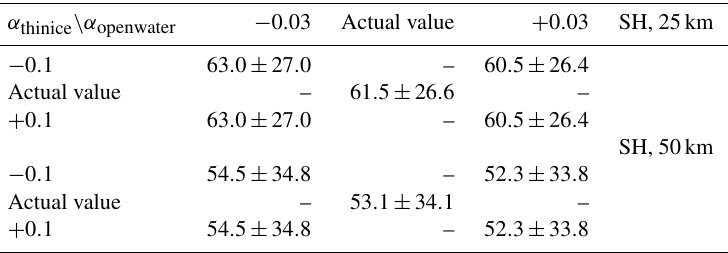
Table 4. Landsat SIC derived using the actual pair of albedo threshold values (“Actual value”) and the four variations of them (see text) averaged for 15 Landsat-8 scenes selected for the Southern Hemisphere (SH) at 25 and 50km grid resolution. The number to the right of the ± denotes 1 standard deviation. All SIC values are in